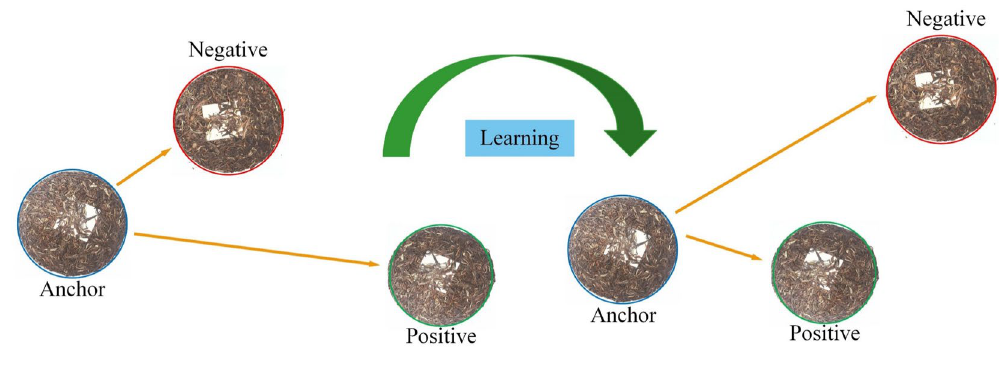
Figure 9. Triplet